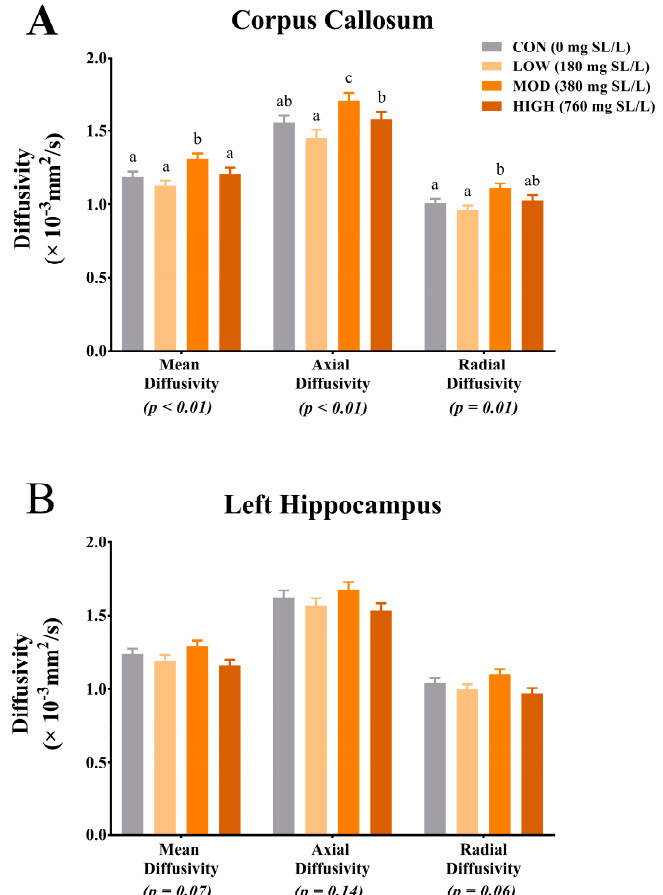
Figure 2. Diffusion tensor measures in the corpus callosum are influenced by dietary sialyllactose (SL). ( A ) Dietary SL influences diffusion tensor measures of mean diffusivity (MD) ( p < 0.01), axial diffusivity ( p < 0.01) and radial diffusivity (RD) ( p = 0.01) in the corpus callosum. For all measures, pigs provided the MOD dietary SL treatment exhibited the highest rates of diffusion; ( B ) Dietary SL tended to influence (0.05 < p < 0.10) diffusion tensor measures of MD ( p = 0.07) and RD ( p = 0.06) in the left hippocampus.